Question: Produce a descriptive caption suitable for publication.
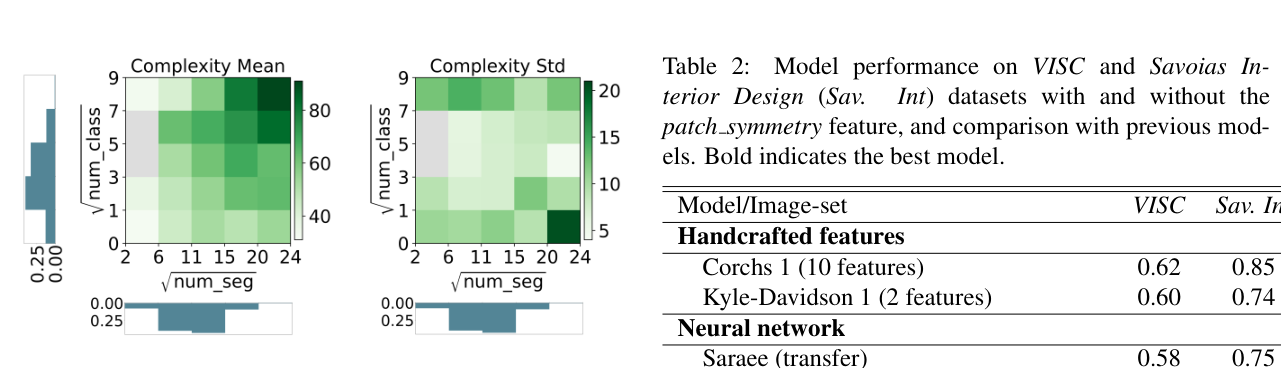
Answer: Mean and standard deviation of the ground truth subjective complexity in different bins of √num seg and √